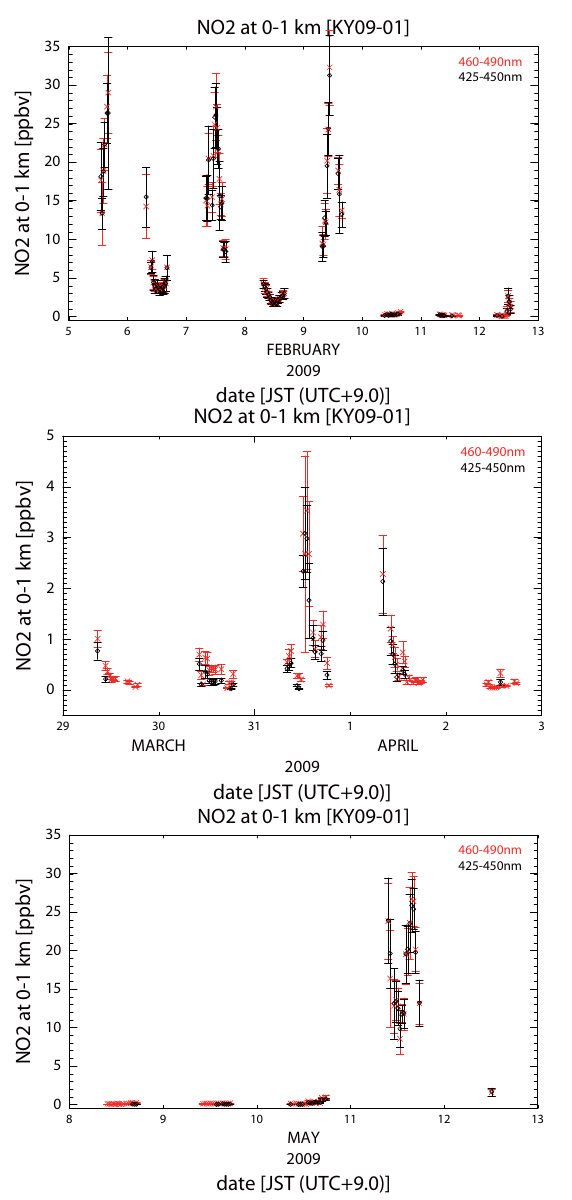
Fig. 5. As for Fig. 4, but for NO 2 concentrations measured on the R/V Kaiyo at 0–1km for fitting windows of 460–490nm (red) and 425–450nm (black).